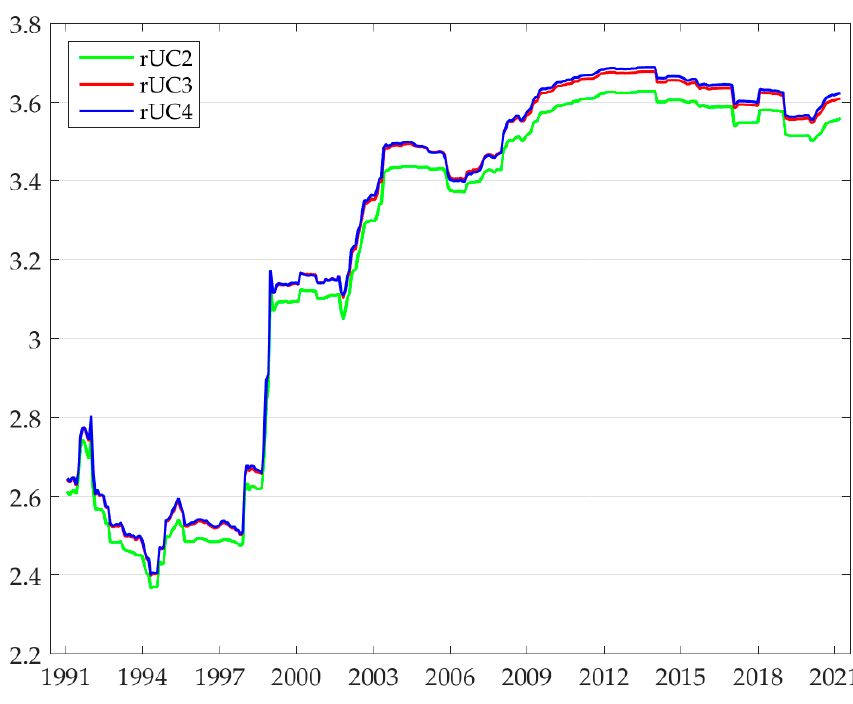
Figure 6. Real user cost aggregates 1991-2021.